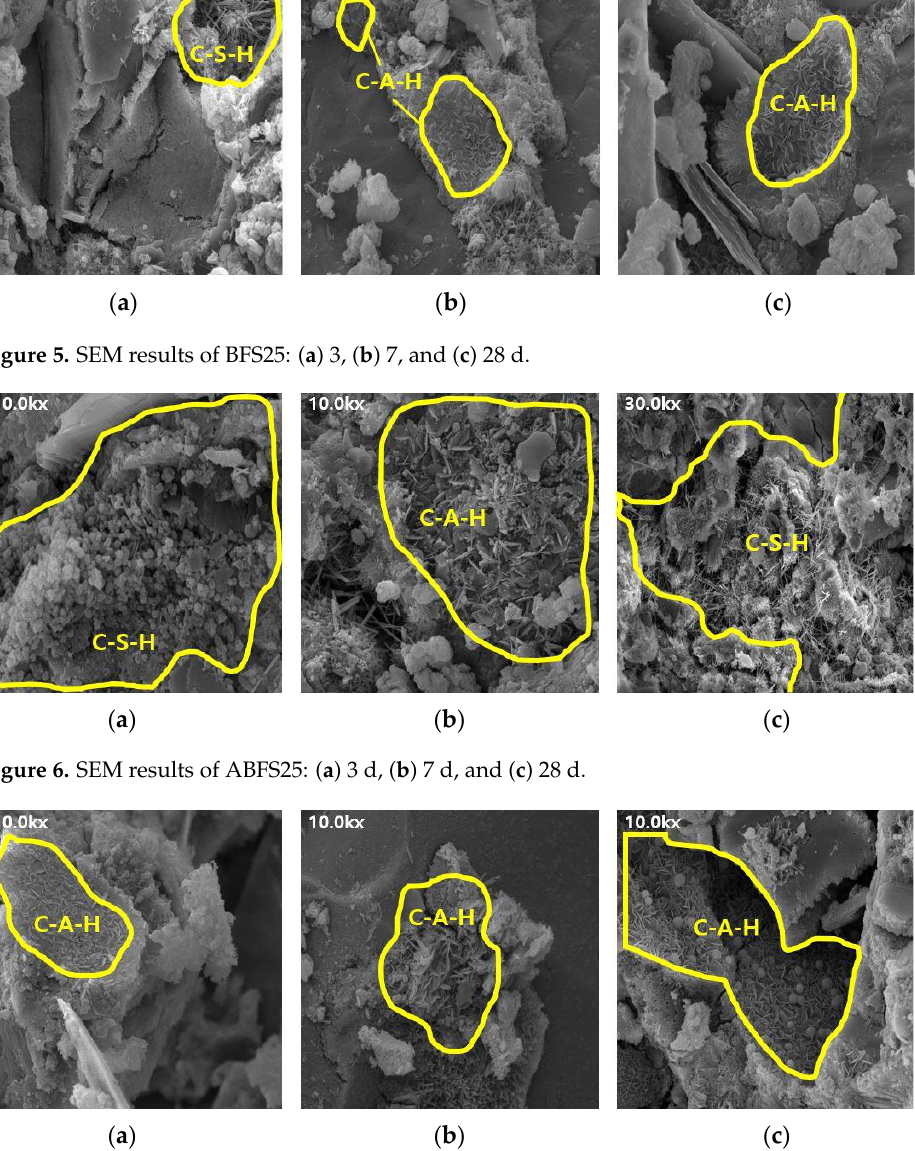
( c ) Figure 8. SEM results of ABFS50: ( a ) 3, ( b ) 7, and ( c ) 28 d. 3.3. Accelerated Carbonation Test Figures 9 – 13 show the accelerated carbonation test results. For the mortar mixed with BFS using conventional mixing water, carbonation proceeded more rapidly compared to the mortar mixed with BFS using alkaline water. In addition, the carbonation depth meas- urement results in Figure 14 show that, for a given age, the carbonation depth increased as the BFS replacement ratio increased. The SEM analysis results indicate that more hydration products were generated in- side the hardened body using alkaline water because an alkaline environment was created at the beginning. The carbonation proceeded slowly because the inner densification af- fected the permeation of CO 2 . ( a ) ( d ) Figure 9. Accelerated carbonation test result of OPC: ( a ) 1, ( b ) 2, ( c ) 3, and ( d ) 4 weeks.